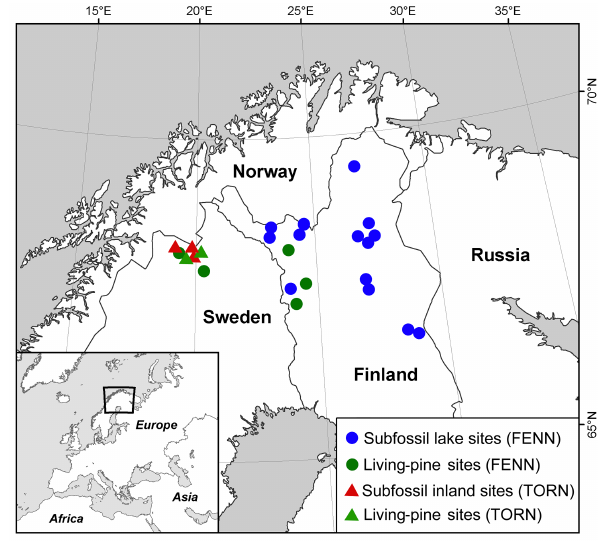
Figure 1. Subfossil and living-pine sites location for FENN and TORN data